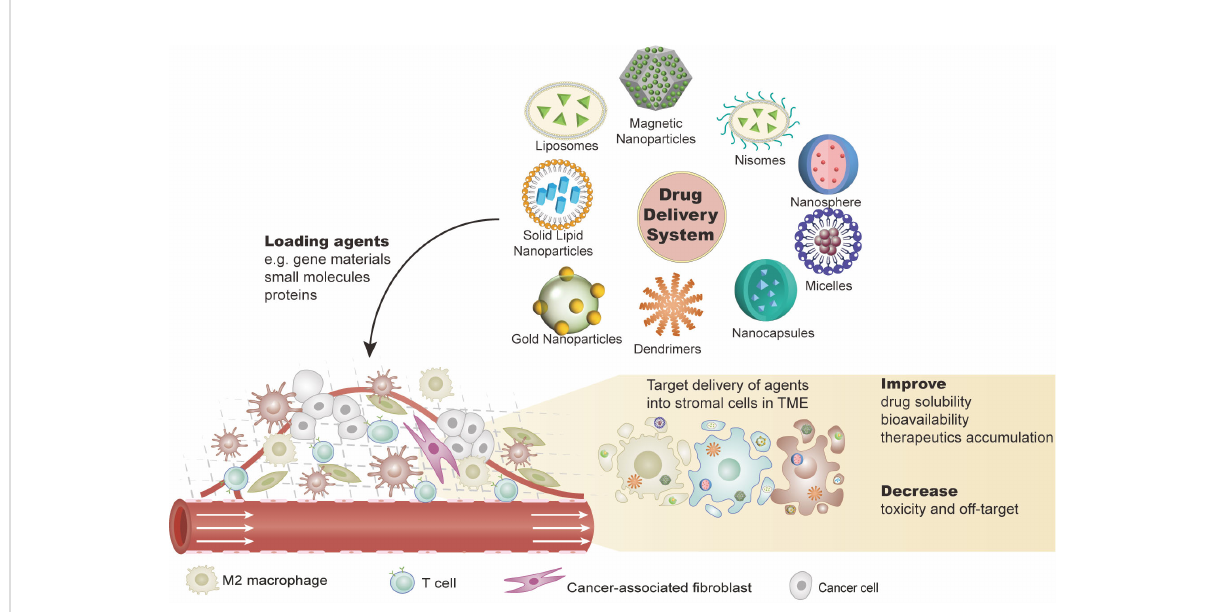
FIGURE 2 Drug delivery systems (DDSs) targeting the ovarian tumor microenvironment (TME). DDSs carry effective agents such as gene materials (e.g., cDNA, mRNA, or miRNA), proteins, or other small molecules (e.g., peptides) into the tumor sites. These agents are expected to work on: 1) eliminating the immunosuppressive cells or transforming them into immunostimulatory phenotypes and 2) inhibiting the immunosuppressive or pro-tumor production of the stromal cell. This combination of agents with DDS not only improves the solubility and stability of the agents but also ful fi lls the target delivery with reduced toxicities. There are various DDS platforms, such as liposomes and